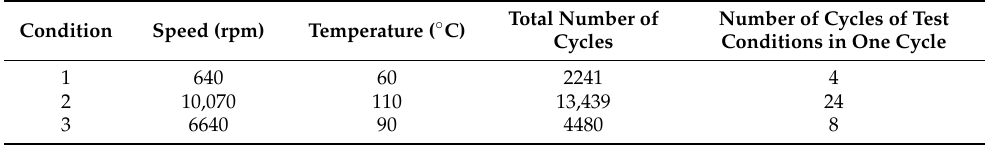
Total Number of Cycles